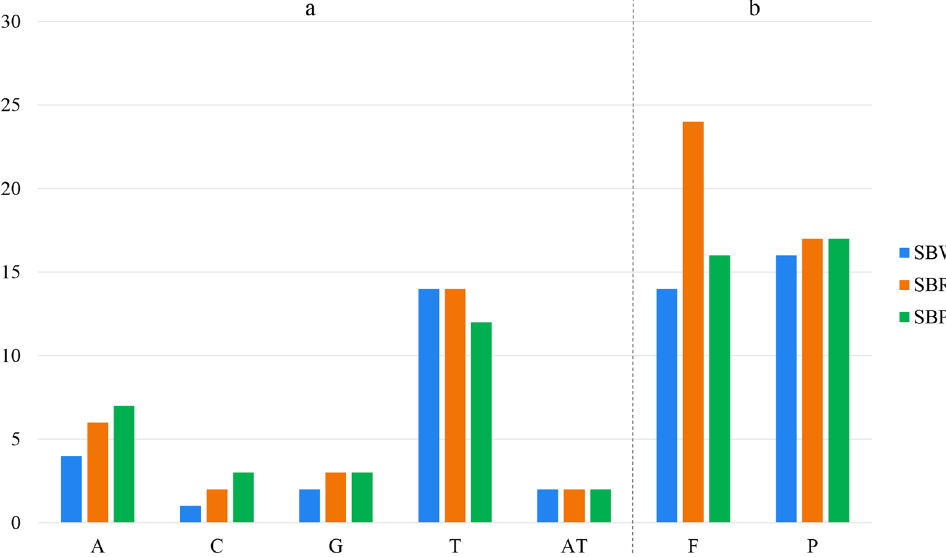
Figure 4. Comparison of repeats in three cultivated varieties. ( a ) SSR distributed situation in the cp genomes of five species. ( b ) Long repeats classification of five species. F—forward repeats; P—palindromic